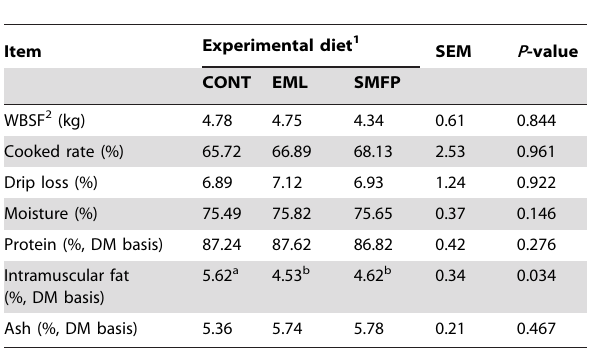
Table 6. WBSF and chemical composition of steak samples of finishing steer fed a total mixed ration supplemented with ensiled mulberry leaves (EML) or sun-dried mulberry fruit pomace